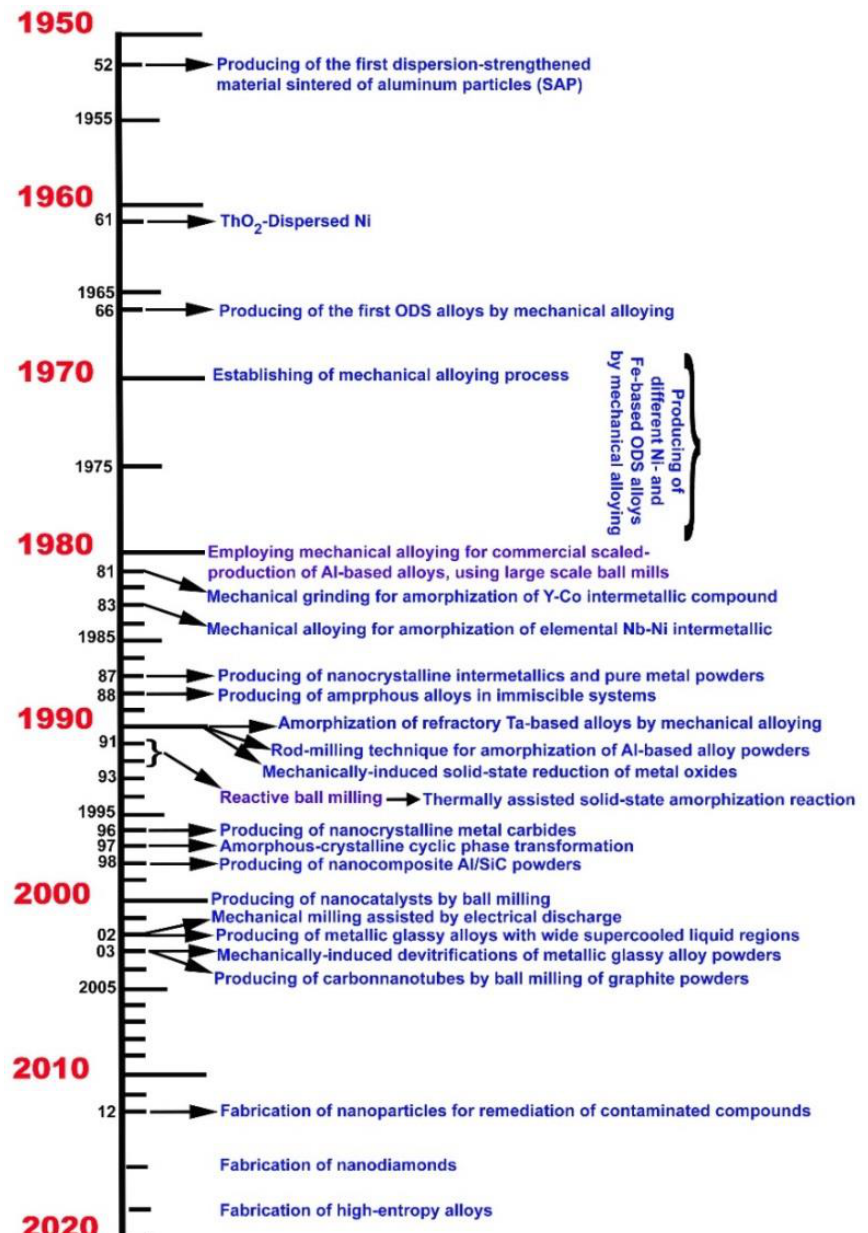
Figure 1. A timeline presentation displaying the evolution of mechanical alloying since 1950, along with some instances of novel materials obtained by this process.